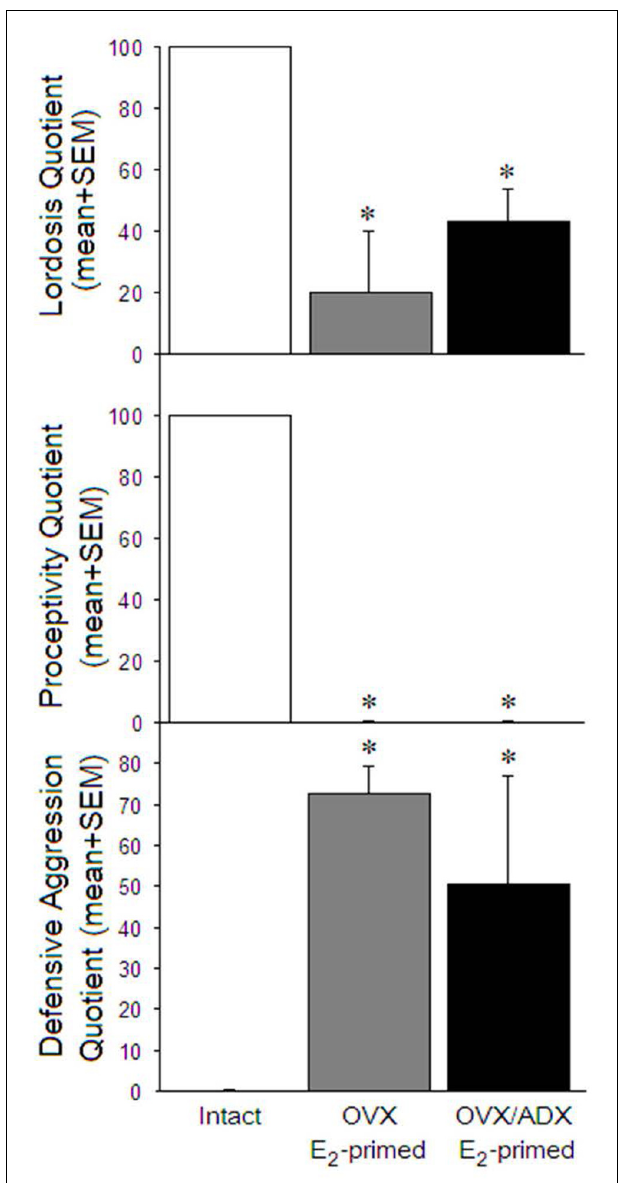
FIGURE 1 | Lordosis quotients (top) and proceptivity quotients (middle) were significantly higher, and defensive aggression quotients (bottom) significantly lower, among naturally receptive rats (left), compared to ovariectomized estradiol primed (middle) and ovariectomized and adrenalectomized estradiol primed (right) sexually-naïve male rats. GH1 was elevated most among naturally mated rats, and was increased similarly among estradiol primed rats whether mated or not. ∗ p < 0.05.